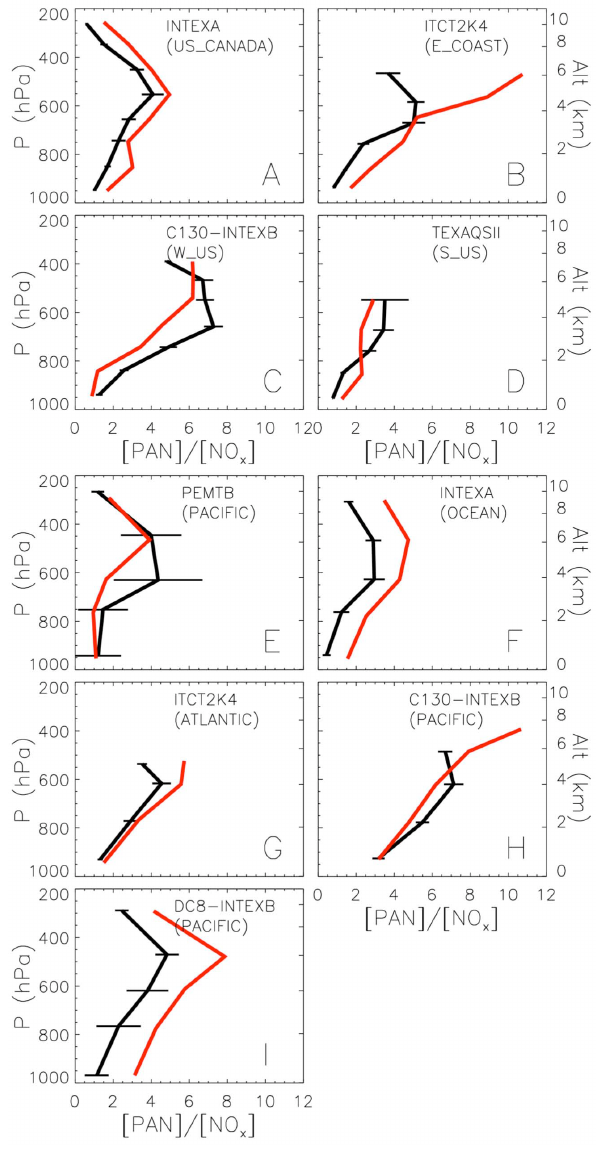
Fig. 11. Vertical profiles of PAN:NO x ratio over the North Ameri- can continent (A–D) and over the ocean (E–I) . Colors as in Fig. 10. See text for